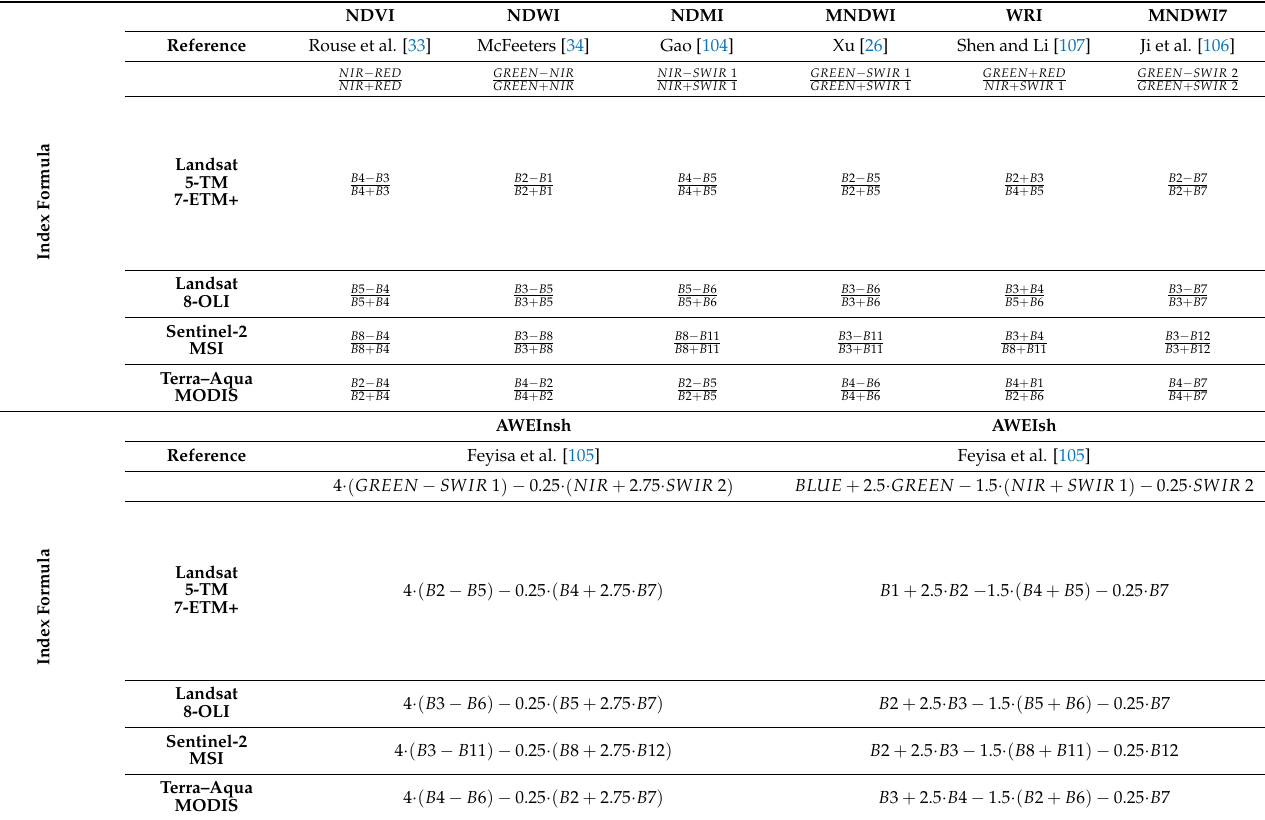
Table 3. Spectral index formulas according to the original band’s composition and formulation for each selected